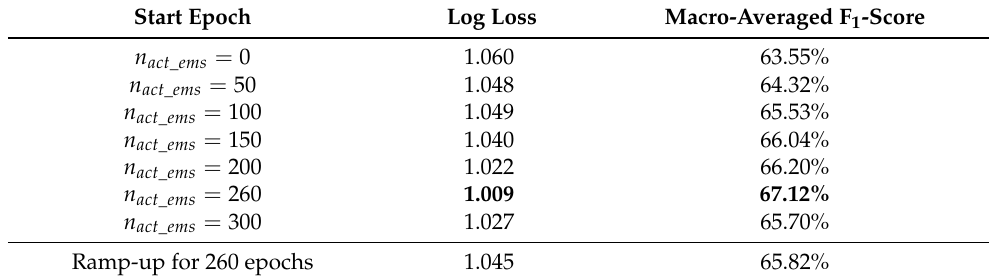
Table 5. Performance comparison with various start epoch parameters n act _ ems for ensemble